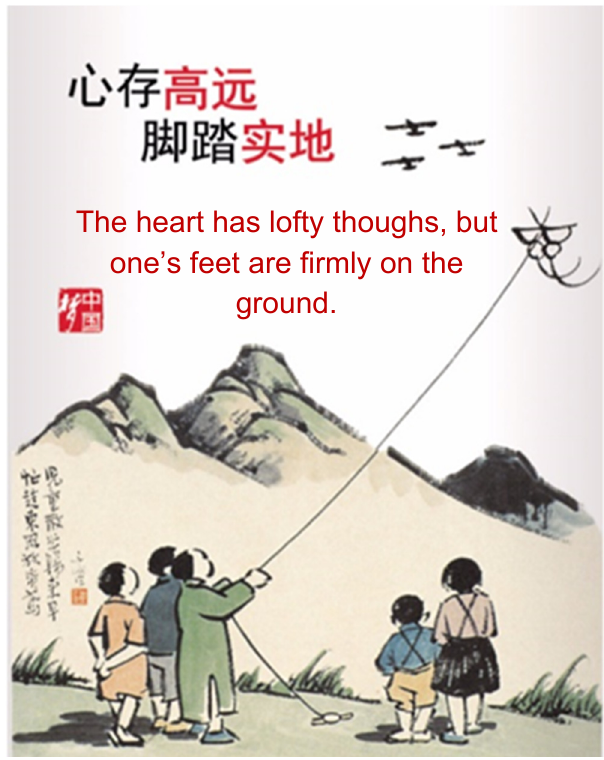
Figure 1. Sample painting reflecting the Chinese philosophy of balancing. Source: